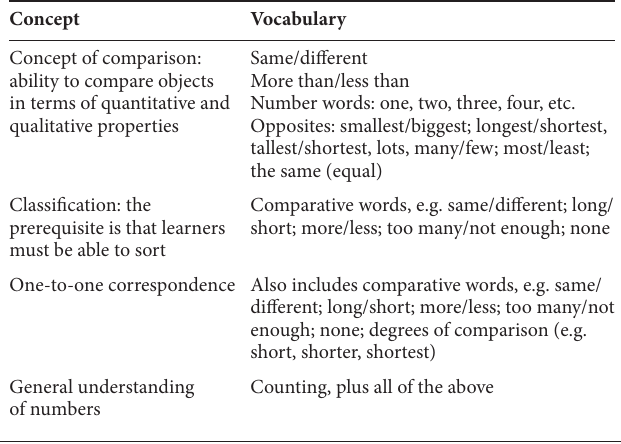
Table 1. Emergent numeracy skills with required matching vocabulary (based on Torbeyns et al ., 2002) Concept